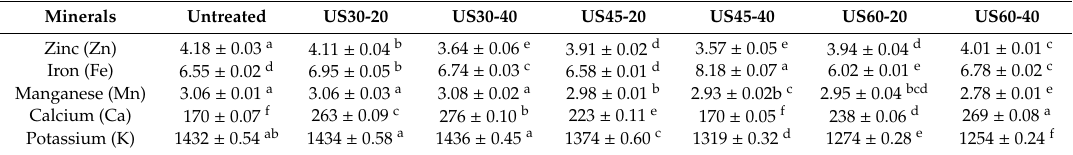
Table 6. Impact of TU treatment on minerals contents (mg /